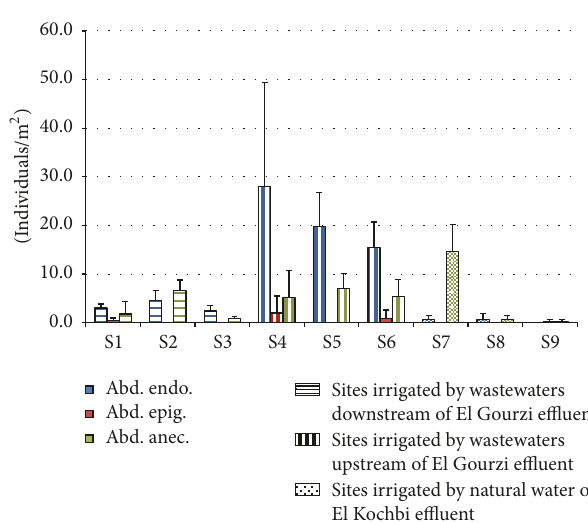
Figure 11: Earthworms’ ecologic categories: abundance in studied soil